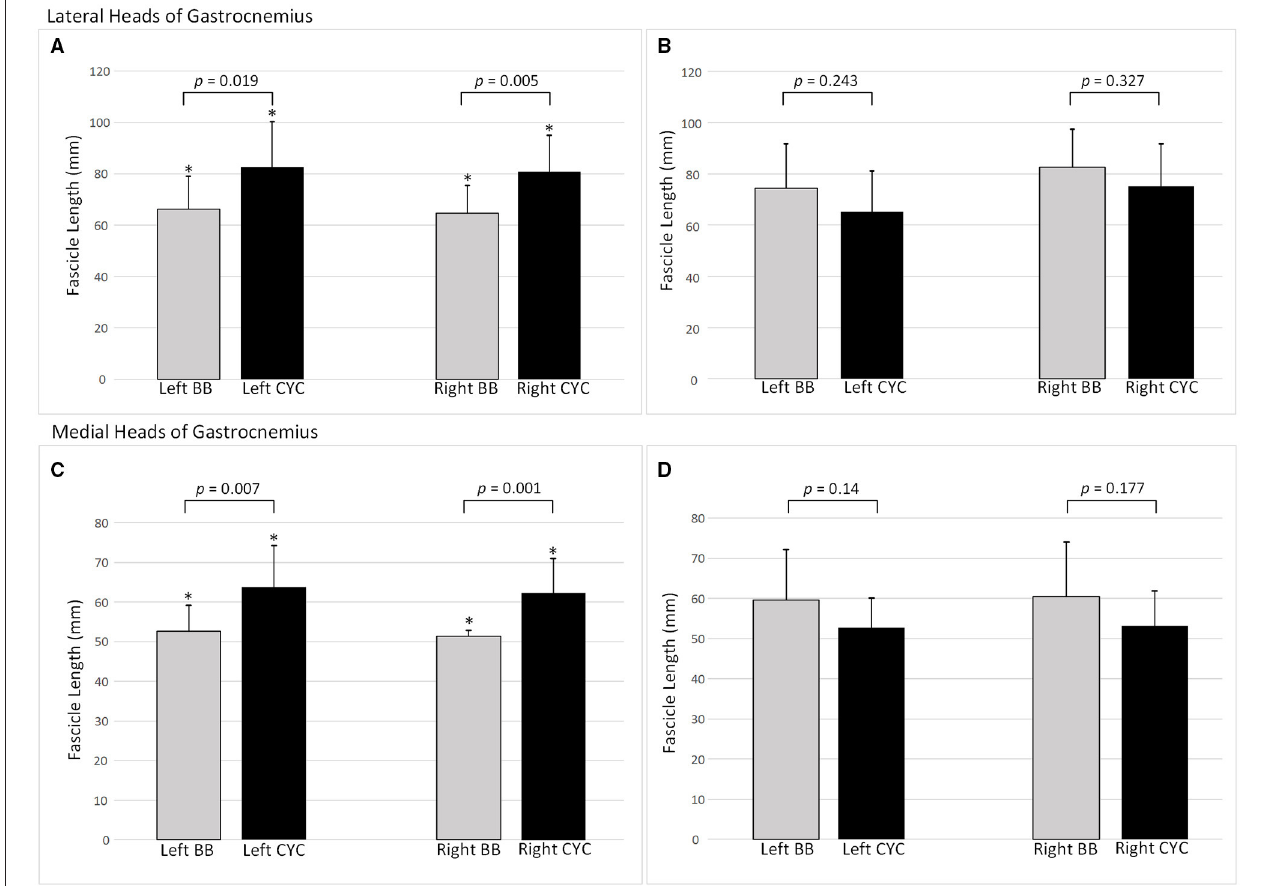
FIGURE 3 | Fascicle lengths by training group and limb side. Mean ± SD . (A) Female lateral heads of gastrocnemius fascicle lengths (FLs); (B) Male lateral heads of gastrocnemius FLs; (C) Female medial heads of gastrocnemius FLs; (D) Male medial heads of gastrocnemius FLs. BB, basketballer; CYC, cyclist; *p-value indicates statistical